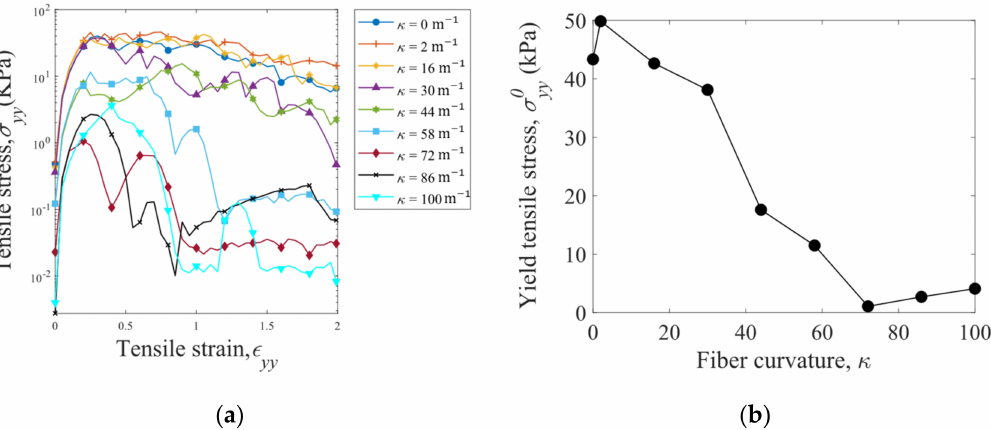
Figure 13. ( a ) Tensile stress σ yy versus tensile strain (cid:101) yy for the S-shaped fibers with various curvatures κ and ( b ) dependence of yield tensile stress σ 0 yy on the fiber curvature. The normalized fiber assembly sample length is specified as L s / d =